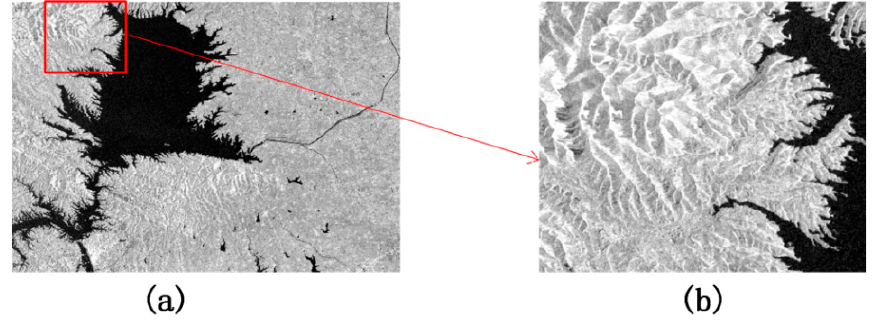
Figure 17. Original and compensated SAR images: ( a ) Original HV polarized Gaofen-3 image; ( b ) part of the enlarged area of ( a ); ( c ) compensated image of ( a ); ( d ) part of the enlarged area of ( c ). 4. Discussion In this study, the classi fi cation of ground objects in complex terrain area was studied by using ascending and descending orbit HH-HV dual-pol mode SAR data from the Gaofen-3 satellite. Through geometric distortion processing and e ff ective feature combi- nation, the classi fi cation confusion relating to complex terrain areas can be e ff ectively im- proved. There are vast mountains and hills on the earth’s land surface, and the SAR side- looking imaging mechanism leads to serious geometric distortion in areas of complex ter- rain. The experimental results show that it is di ffi cult to identify land objects using the sca tt ered signal of the distorted area without processing. In this study, 86.3% of the geo- metric distortion was compensated by the data of the lifting orbit, greatly improving the incorrect sca tt ering information in the geometric distortion area. Because of the imaging angle of the SAR sensors, even sensors with opposite orbits cannot guarantee that all the collected information is correct. The current data for the re- search area are Gaofen-3 dual-track data for compensation and fusion, but there are still a few geometric distortion areas that cannot be compensated. Orbit data from di ff erent an- gles should be added to ensure the integrity of collected information. Furthermore, e ff ective feature combination is an important guarantee of classi fi cation accuracy. In addition to enhancing the separability between land-cover types, DpRVI has been introduced and assessed. DpRVI is mainly used to re fl ect the growth state of vege- tation and the inversion of soil moisture, while its role in land-cover classi fi cation has rarely been investigated, especially in relation to HH-HV dual-pol mode SAR data. It was found that the introduction of DpRVI in HH-HV dual-pol mode is e ff ective and can sig- ni fi cantly increase the J-M distance between woodland and farmland. The application of DpRVI deserves more a tt ention in follow-up research into land-cover classi fi cation. Finally, a 2D-CNN classi fi cation model was constructed. The results show that the classi fi cation accuracy was greatly improved by geometric distortion compensation and e ff ective feature combination with DpRVI.